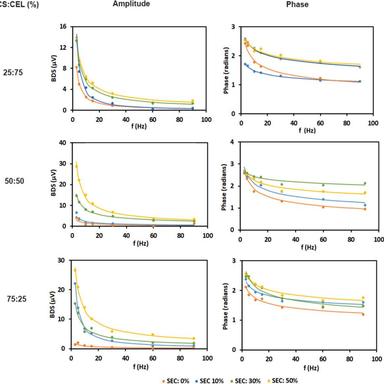
The BDS amplitude and phase dependence on the modulation frequency f of EB for CS:CEL:SEC composites.